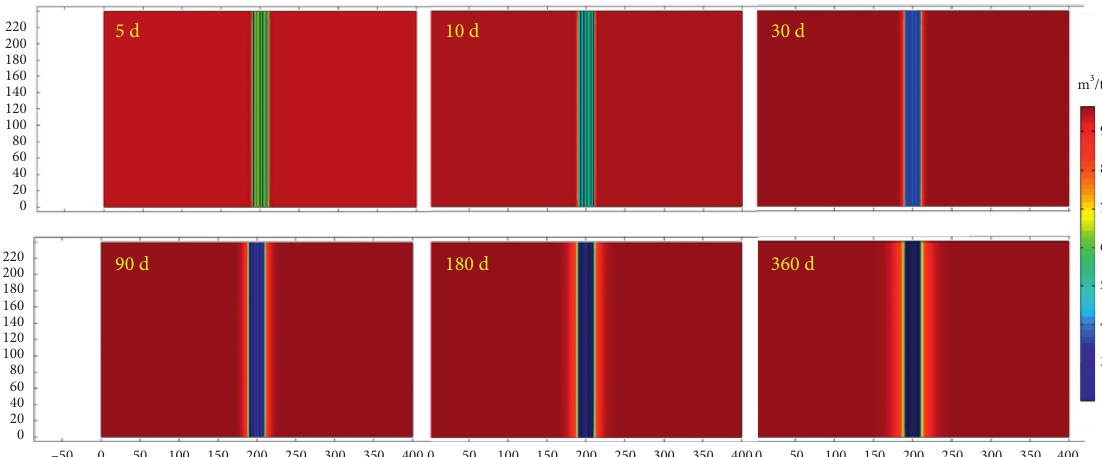
Figure 5: Cloud map of coal seam gas content under different drainage time in the case of long boreholes along the